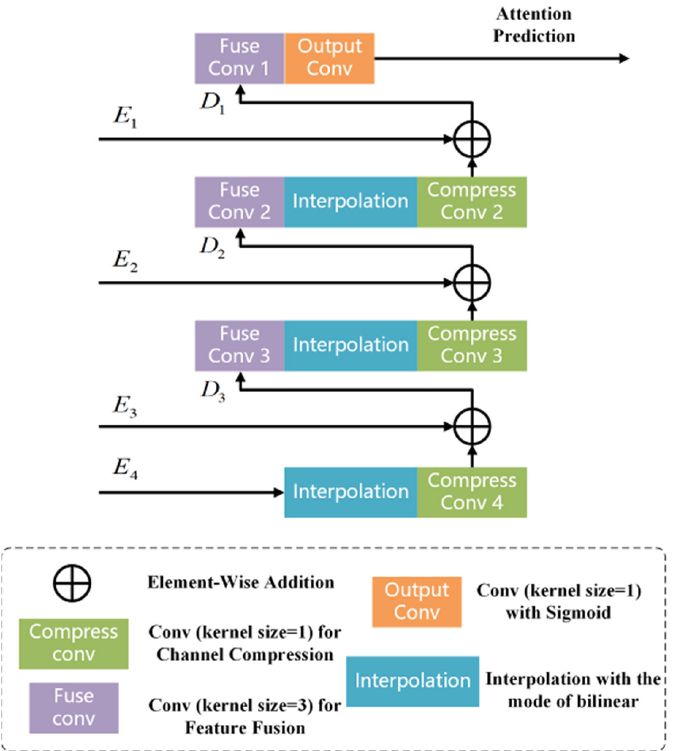
Figure 3. The illustration of the attention guiding decoder. It receives the multi-scale features from Swin Transformer blocks, and then performs attention feature fusing and up-sampling, which plays a role of refining the feature representations and improving the quantity of segmentation.